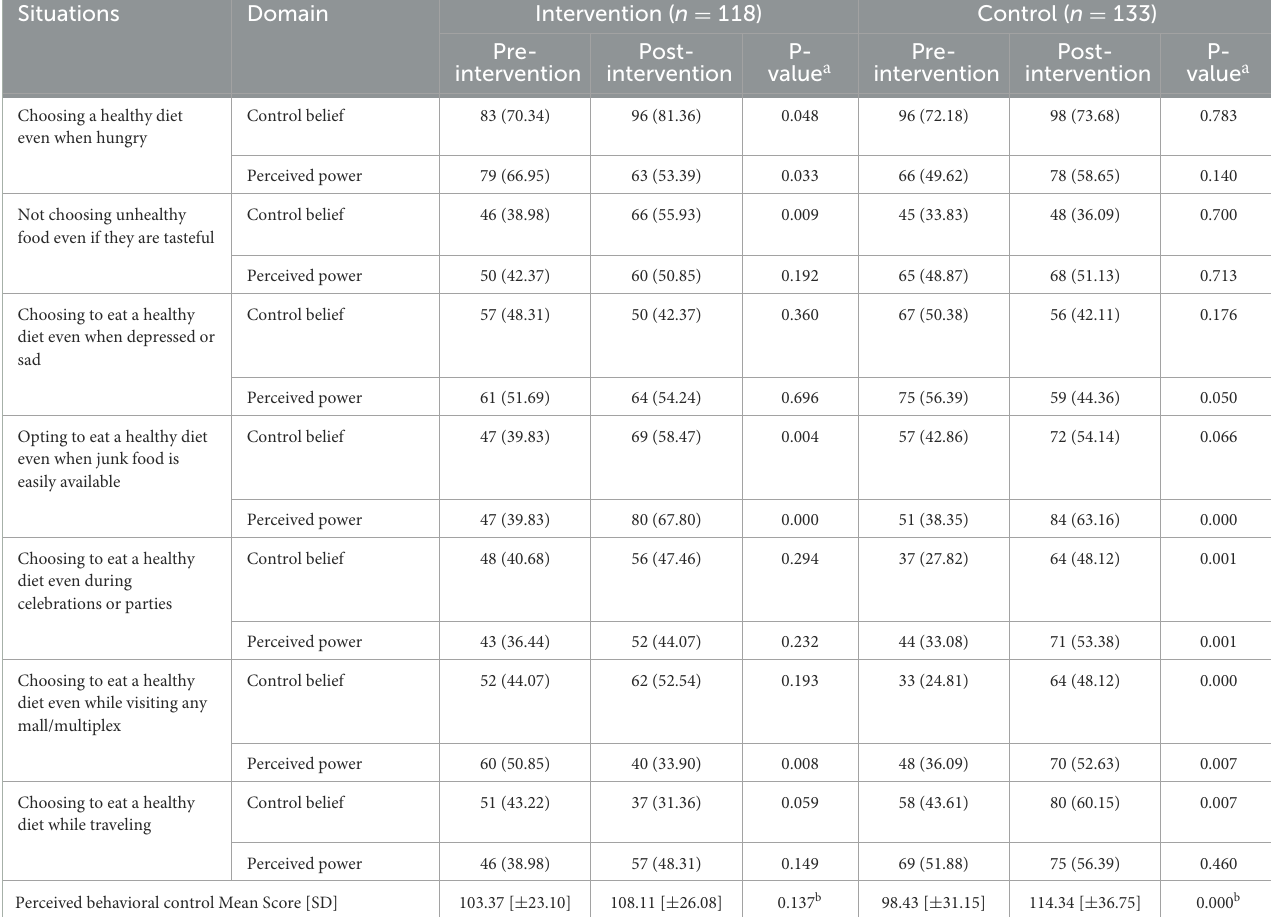
TABLE 5 Pre- and post-intervention comparison of perceived behavioral control regarding consumption of healthy diet among intervention and control groups.